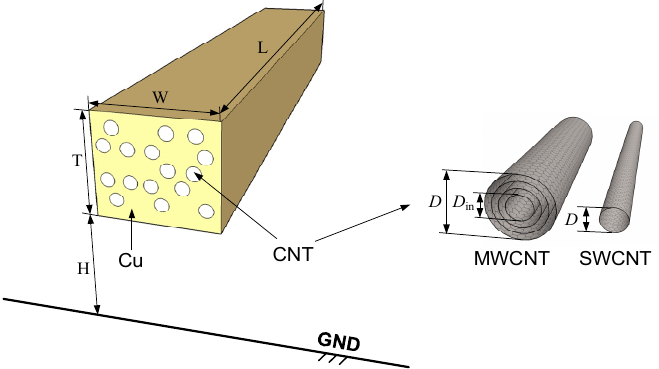
Figure 18. Schematic of Cu-CNT composite interconnect.